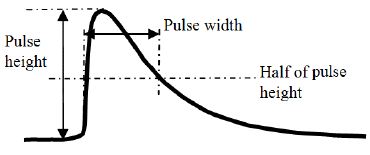
Fig. 6. Pulse-width measurement method.